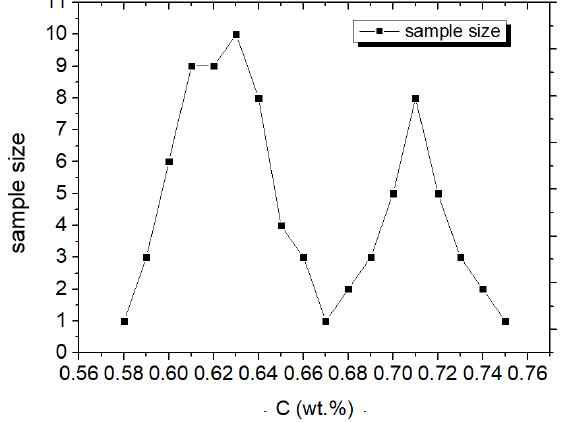
Figure 2. Sample size.